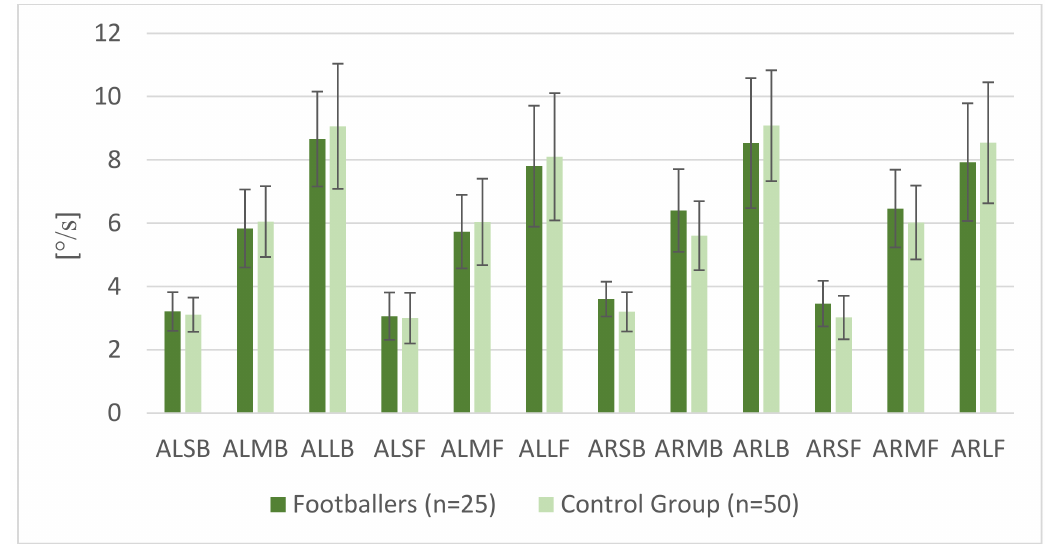
Figure 6. Motor Control Test—amplitudes of the postural responses for left (AL) and right (AR) lower limb for small, medium and large platform transitions in backward (SB, MB, LB) and forward (SF, MF, LF) direction for footballers and control